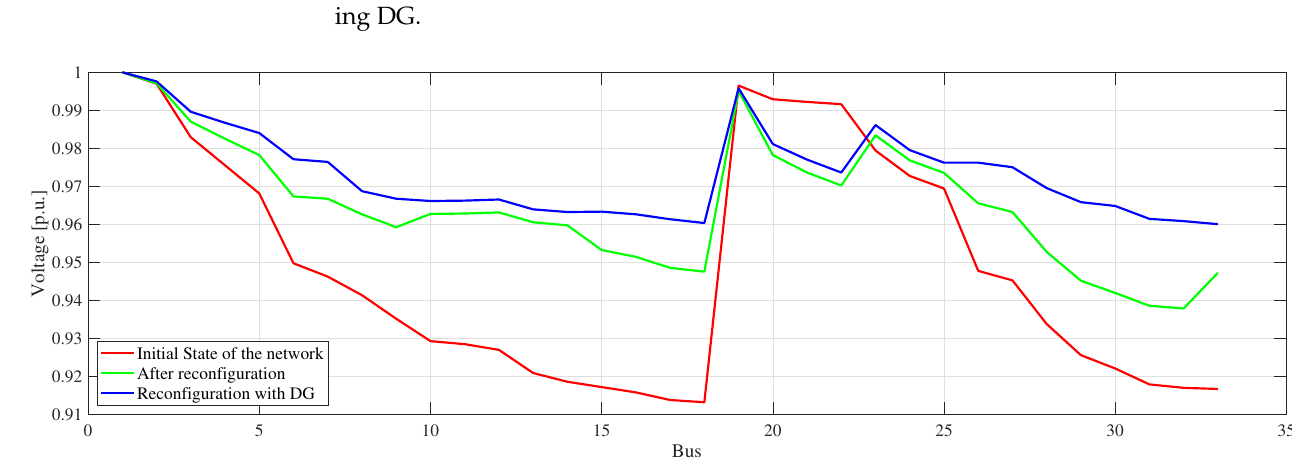
Figure 3. Voltage profile of the 33-bus test